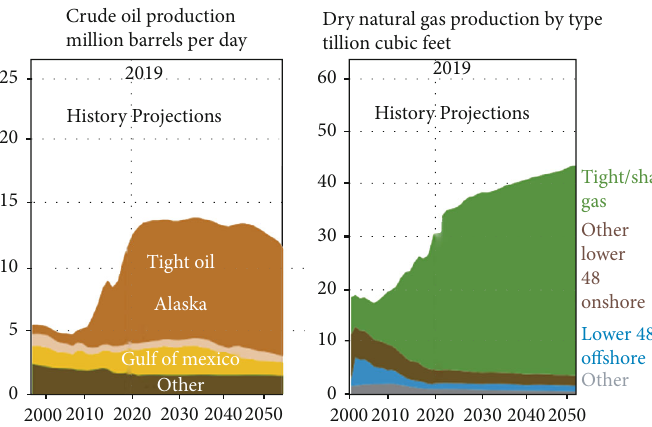
Figure 1: Historical and projected sources of crude oil and natural gas in the US (EIA,